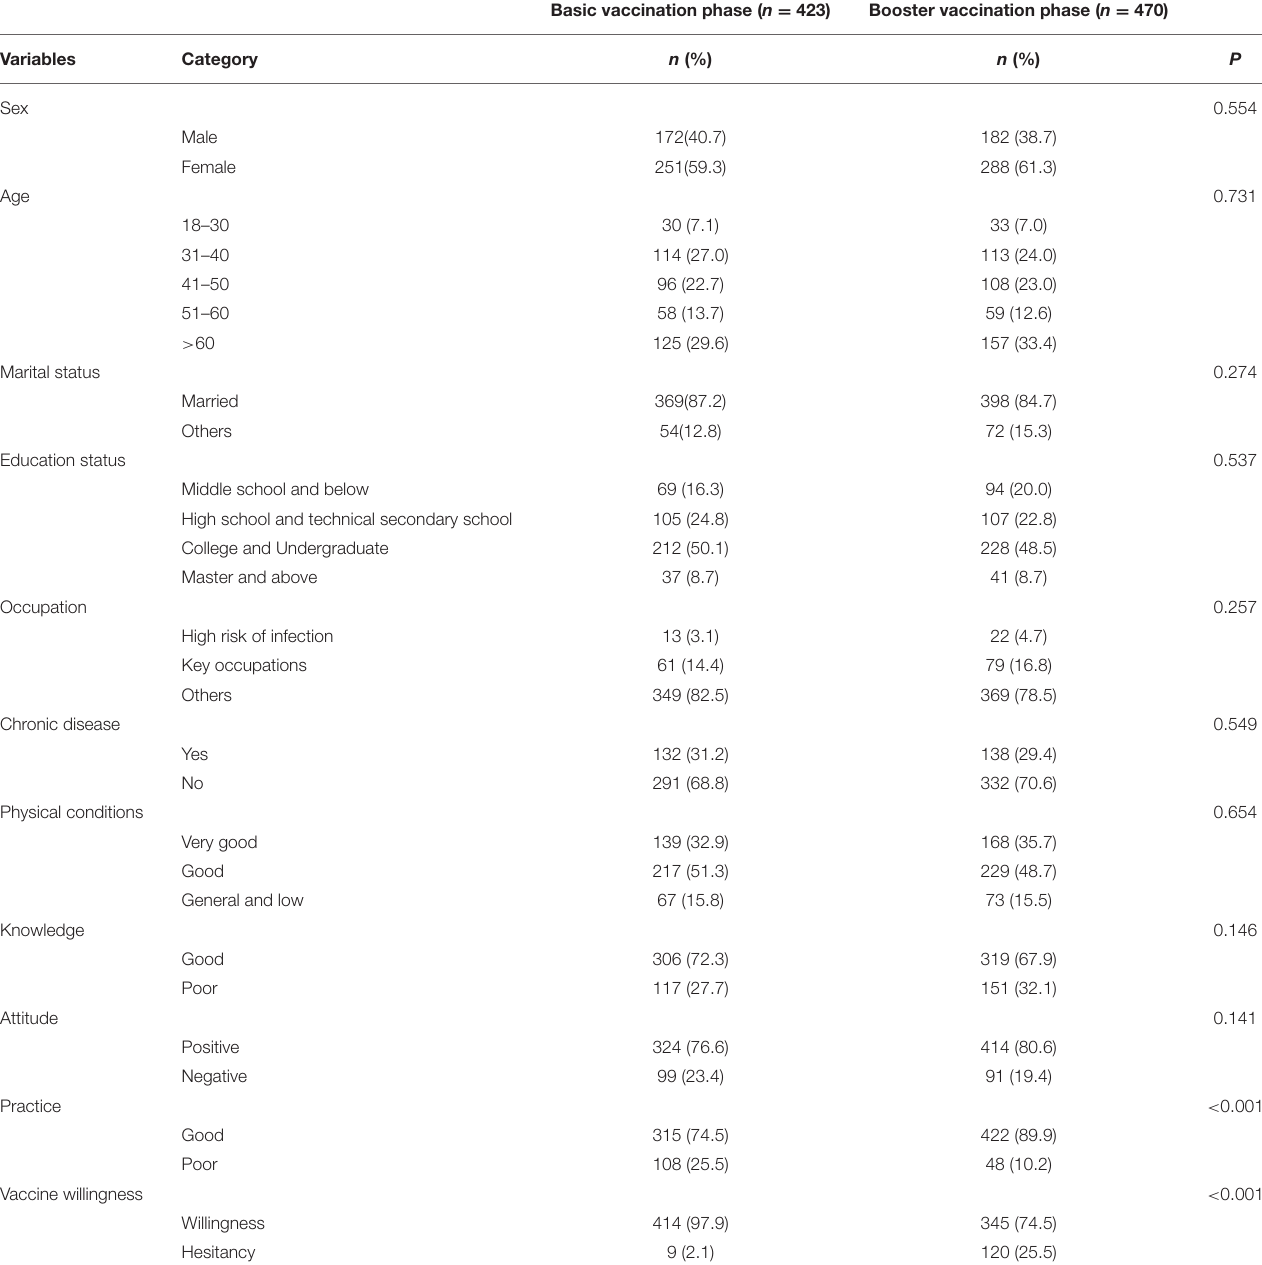
TABLE 1 | Comparison of resident characteristics in two